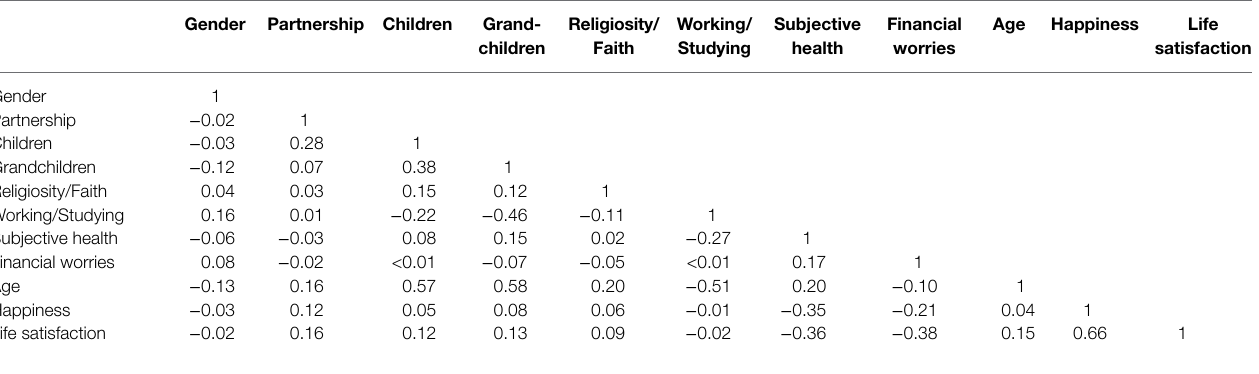
TABLE 3 | Correlations between dependent and independent variables.